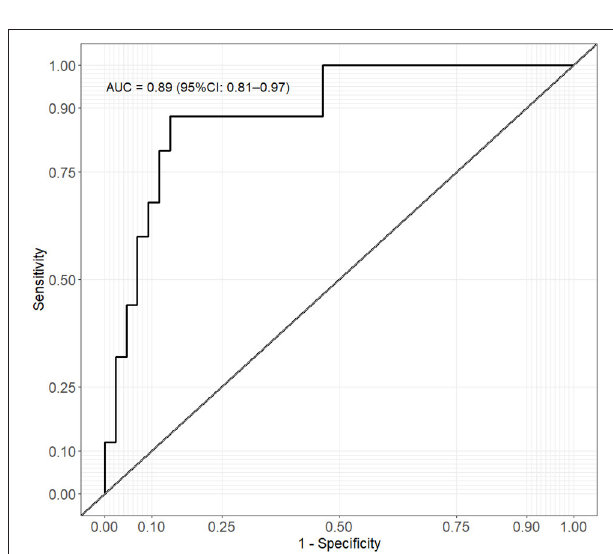
FIGURE 3 | Receiver operating characteristic (ROC) curve analysis of KC_index and clinical GMA (normal vs.